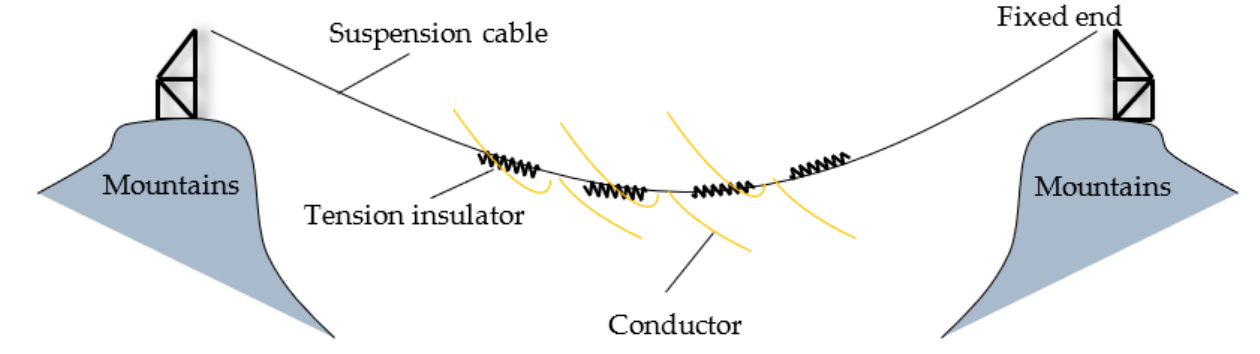
Figure 1. Long-span cross-rope suspension overhead transmission line.